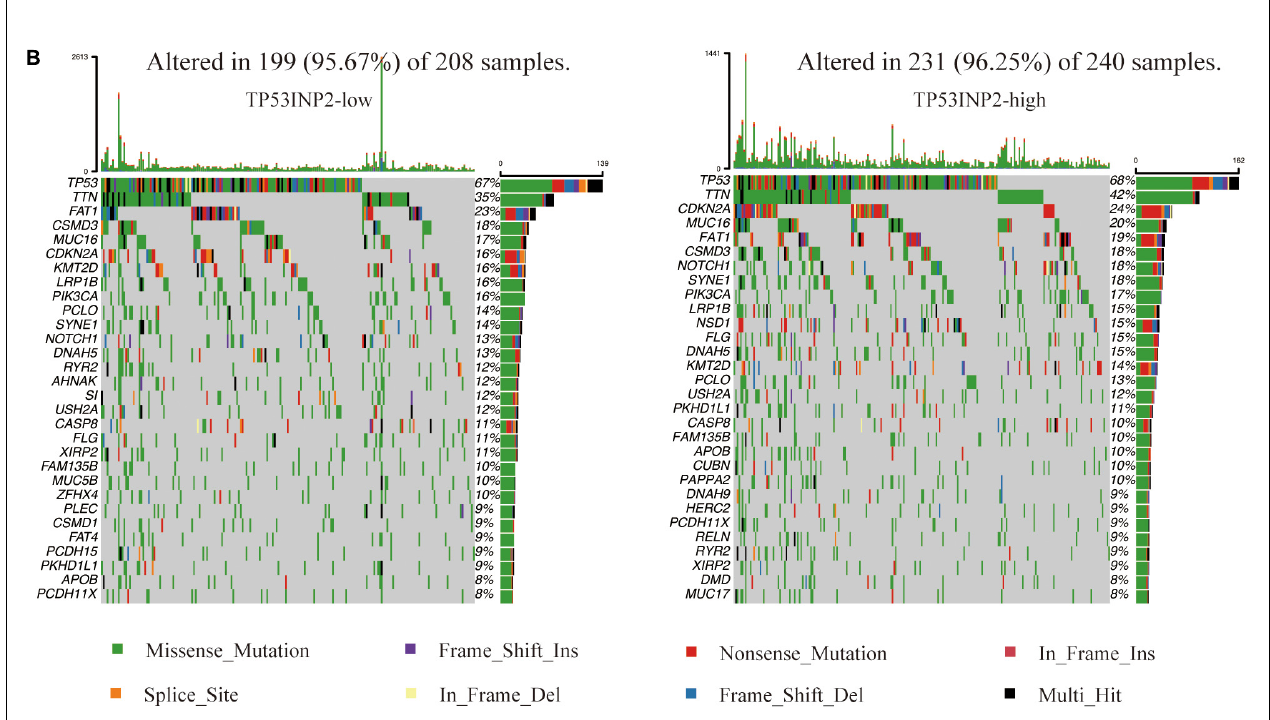
FIGURE 5 | Distinct genomic profiles are correlated with TP53INP2 expression. (A) GISTIC 2.0 amplifications and deletions in TP53INP2-high and TP53INP2-low. (B) Somatic mutations in TP53INP2-high and TP53INP2-low.